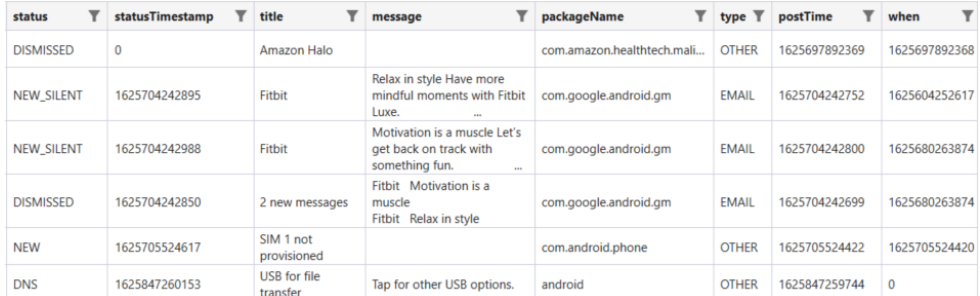
Figure 20. A reduced view of the notifications displayed on the Garmin vívosmart ® 4